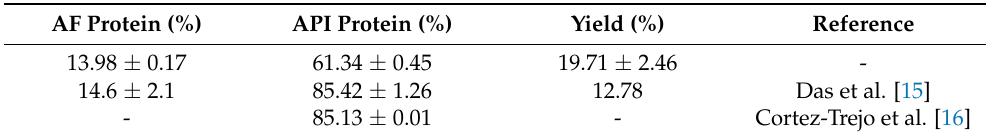
Table 1. Protein concentration (%P; N × 5.85) on dry basis and extraction yield of amaranth protein isolates.